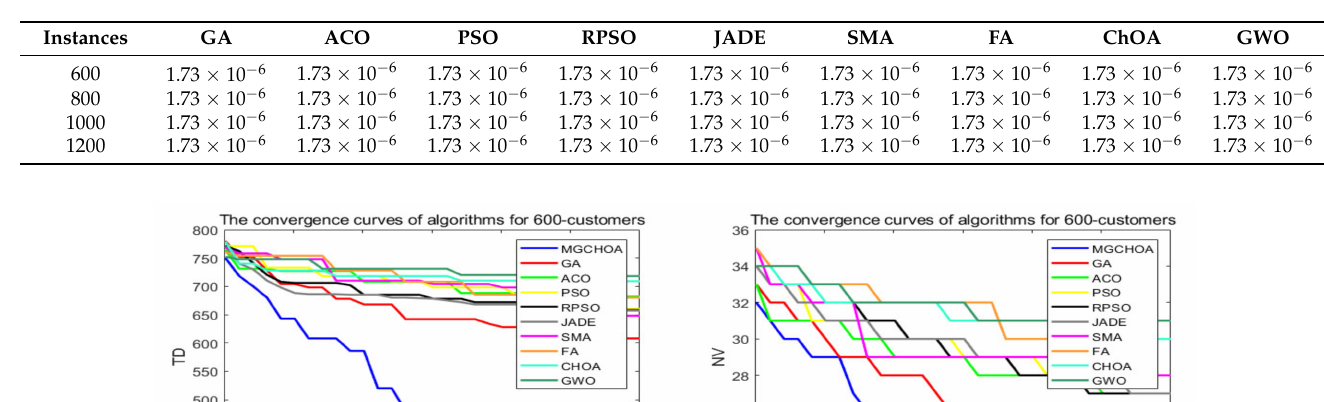
Table 7. The Wilcoxon rank-sum test results for high-dimensional instances.